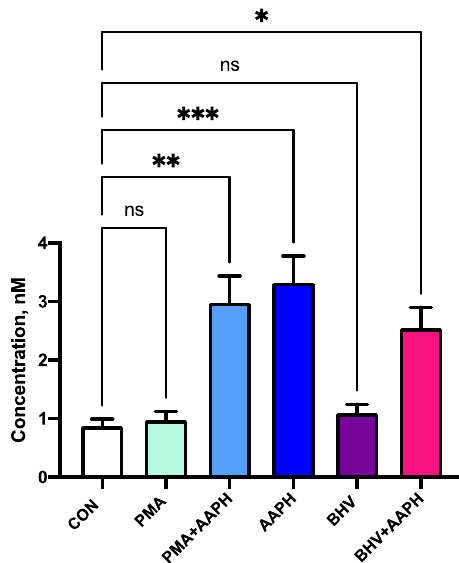
Figure 4. Viability of PBMCs after 12 h of incubation with the different treatments. Results are expressed as estimated means ± SEM of relative luminesce units (RLU). CON = Untreated periph- eral mononuclear blood cells (PBMCs); PMA = PBMCs treated with 10 ng/mL phorbol 12- myristate 13-acetate (PMA) and 1 μ g/mL ionomycin; PMA + AAPH = PBMCs treated with 10 ng/mL PMA, 1 μ g/mL ionomycin, and 3 mM of 2,2 ′ -Azobis(2-amidinopropane) dihydrochloride (AAPH); AAPH = PBMCs treated with 3 mM AAPH; BHV = PBMCs treated 8 × 10 4 TCID 50 Bovine Herpesvirus 1 per 1 × 10 6 PBMCs; BHV + AAPH = PBMCs treated 8 × 10 4 TCID 50 Bovine Herpesvi- rus 1 per 1 × 10 6 PBMCs and 3 mM AAPH; LPS = PBMCs treated with 2 µg/mL E. coli lipopolysac- AAPH; LPS = PBMCs treated with 2 µ g/mL E. coli lipopolysaccharide (positive control). Differences charide (positive control). Differences between treatments and the control were assessed with between treatments and the control were assessed with Dunnett’s pairwise post hoc test. * p < 0.05, **** p < 0.0001, ns: p > 0.05.